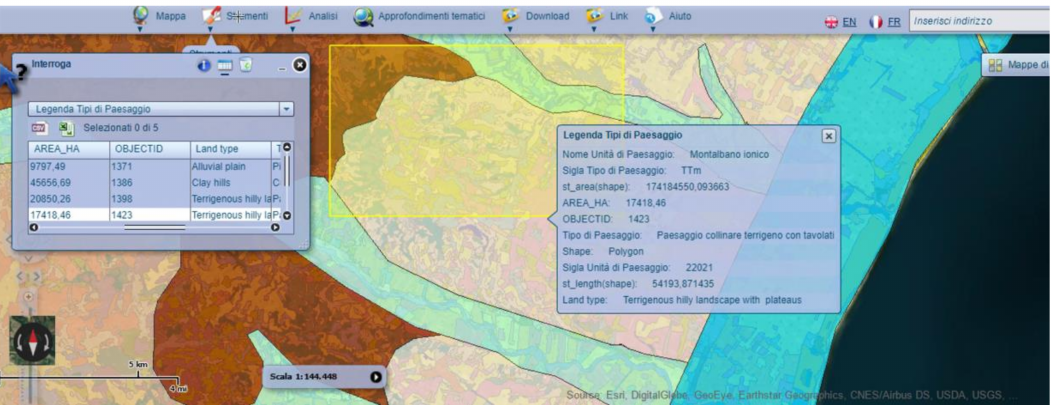
Figure 5. Image and information of the case study as displayed by the geographical information system (GIS) Carta della Natura